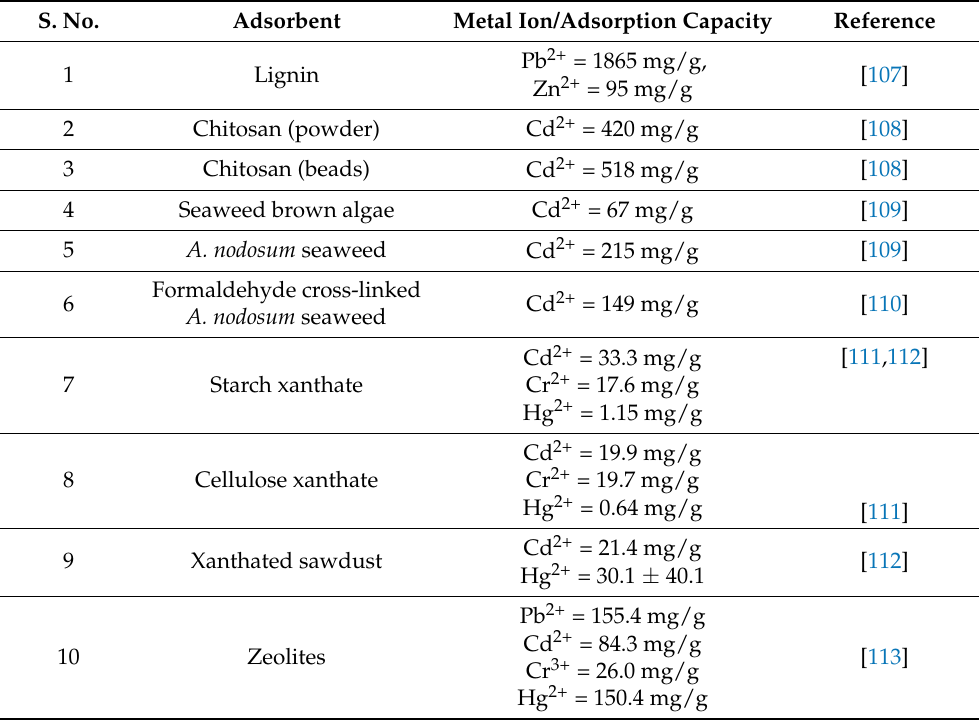
Table 2. Comparison of adsorption capacities of natural adsorbents for removal of toxic metal ions. S.